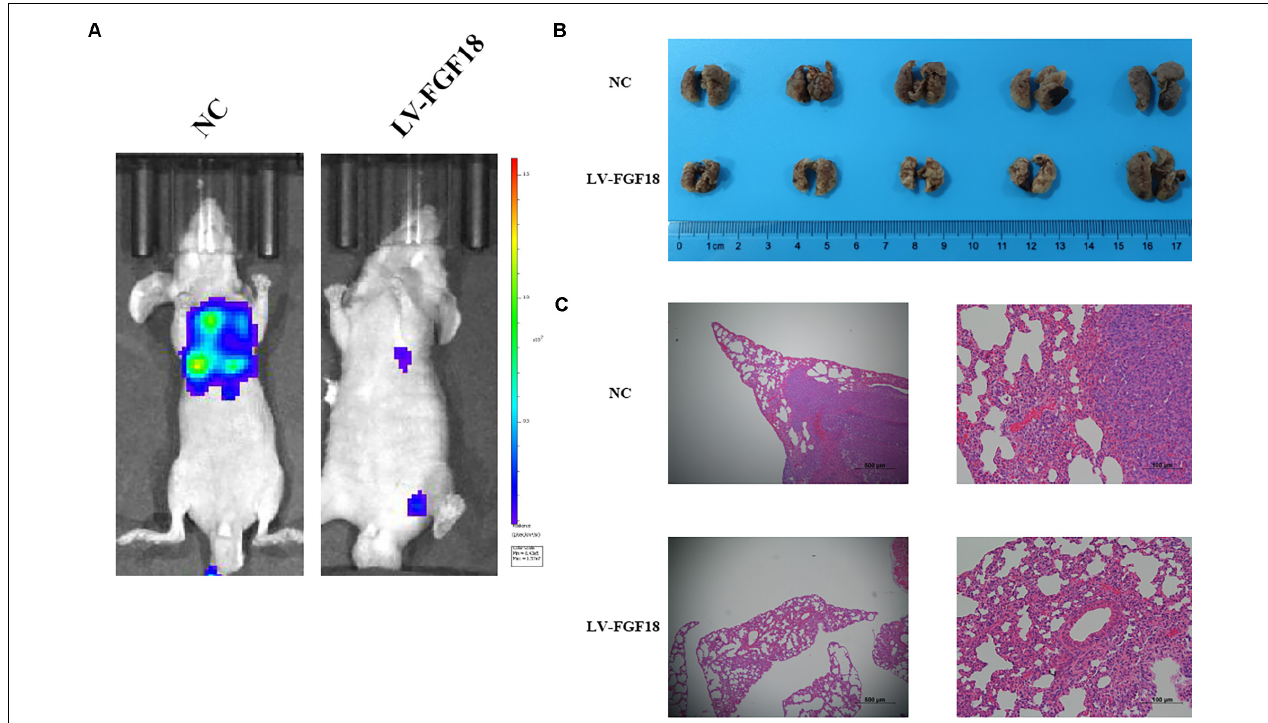
FIGURE 7 | Overexpression of FGF18 inhibits the metastasis ability of ccRCC cell in vivo . (A) Live imaging showed the effect of overexpression of FGF18 on metastasis of 786-O-NC-luc cells or 786-O-FGF18-luc cells 30 days after tail injection. (B) Representative photographs of lung metastasis of nude mice ( n = 5). (C) HE staining of lung metastasis sites of 786-O-NC-luc cells or 786-O-FGF18-luc cells in the nude mice metastasis model.